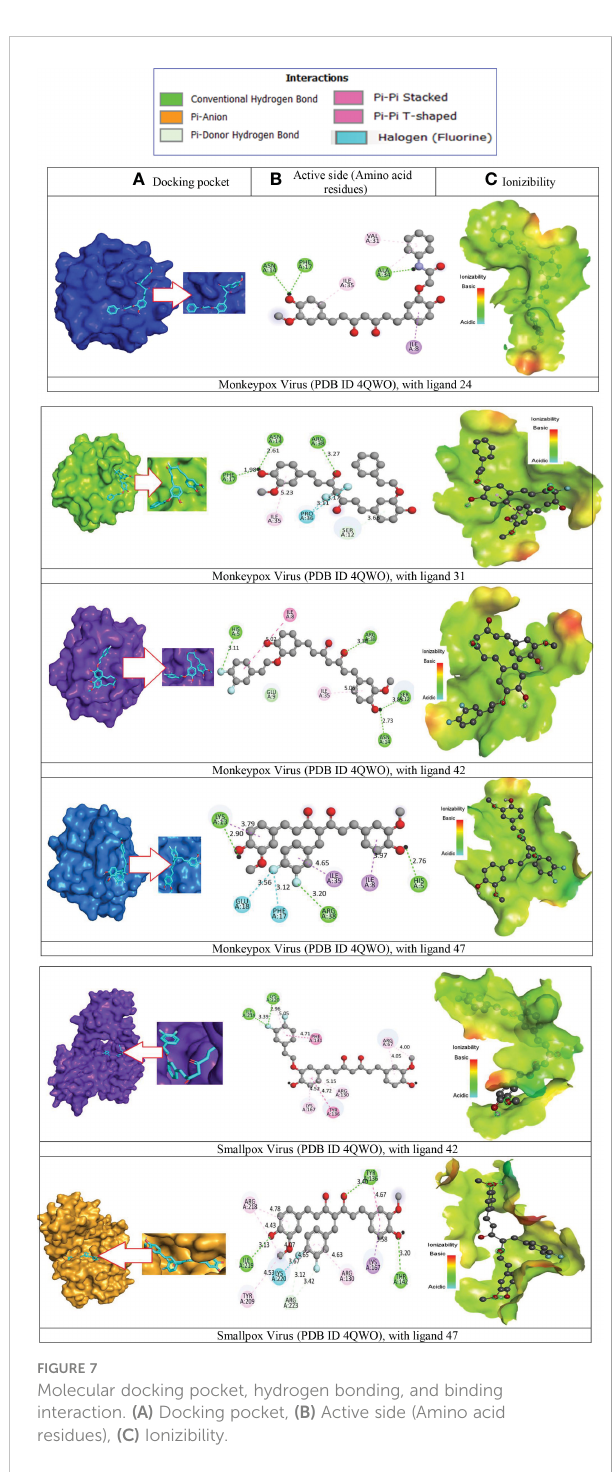
FIGURE 7 Molecular docking pocket, hydrogen bonding, and